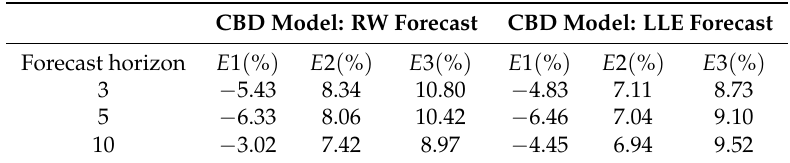
Table 4. Forecasting results of the CBD model for GB males aged 50–89 based on mortality data since